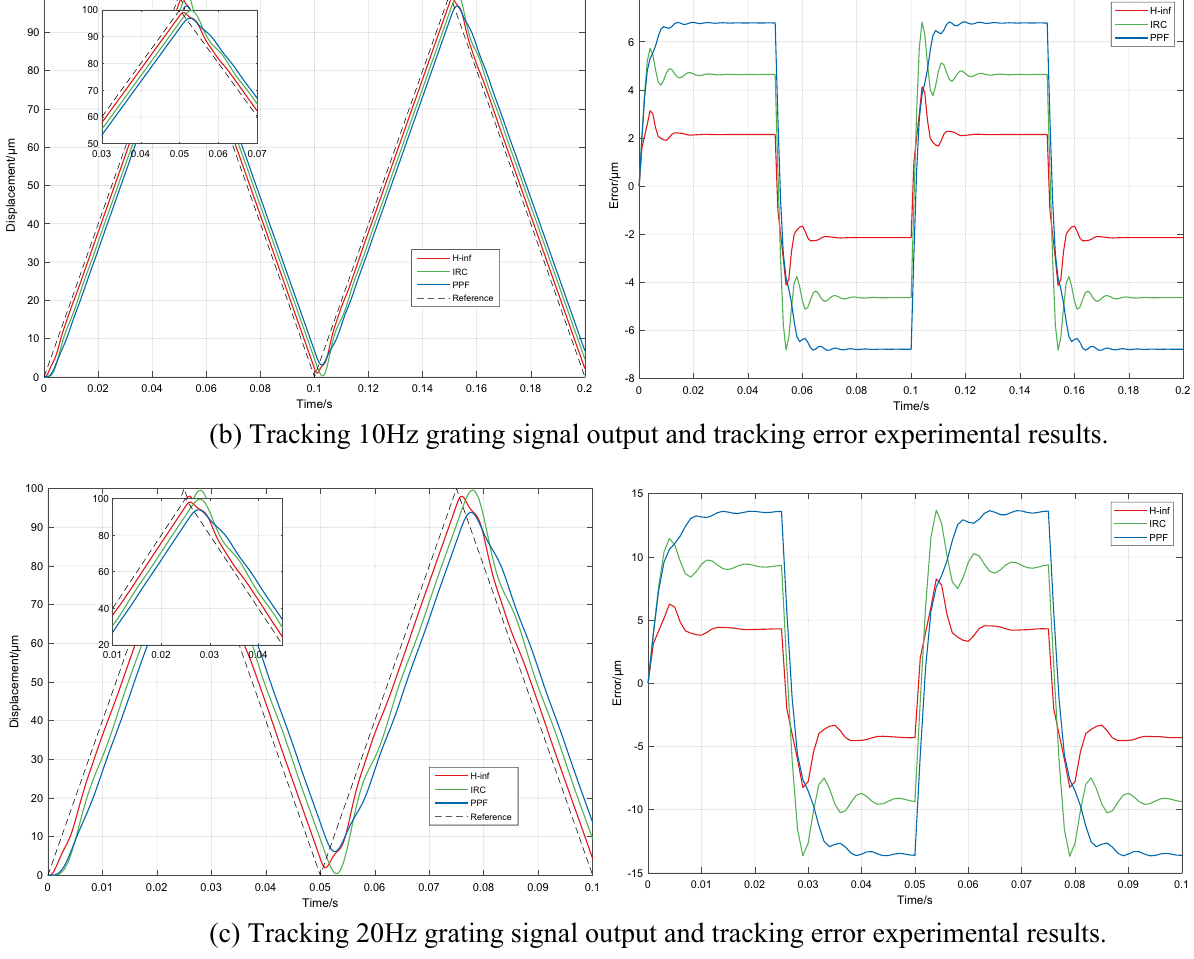
Figure 8. System tracking results for 5, 10 and 20 Hz grating input signals at 0 g mechanical